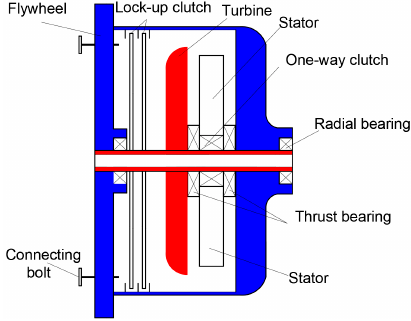
Figure 1. Structure of torque converter.